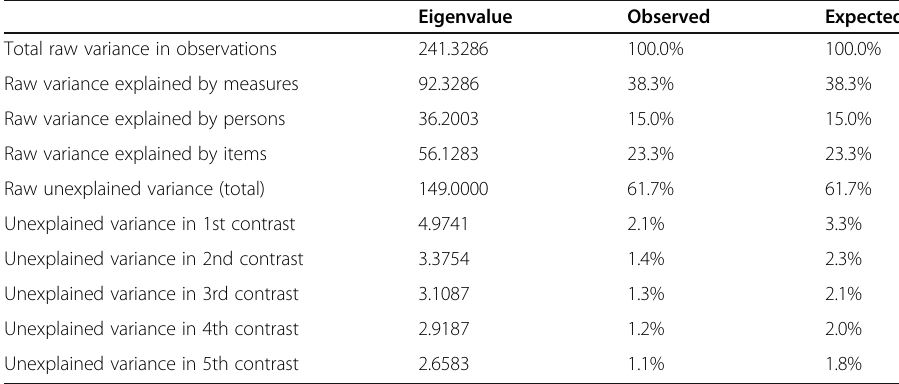
Table 3 Standardized residual variance in eigenvalue units Eigenvalue Observed